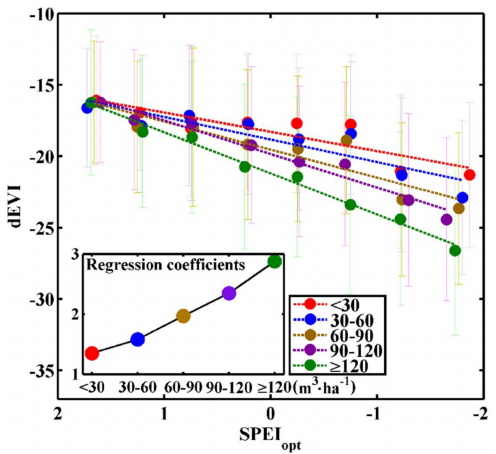
Figure 5. Sensitivity to drought of forests of varying stock volume densities.